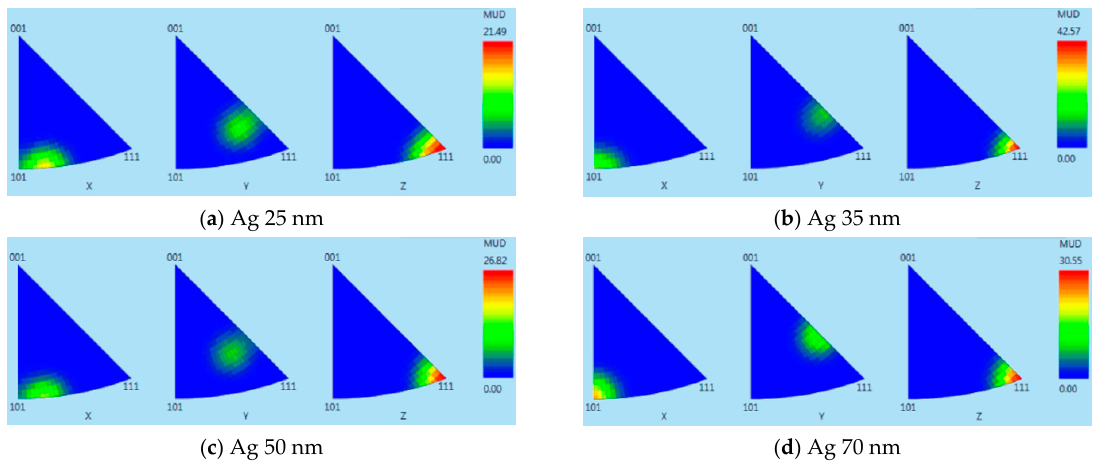
Figure 6. Inverse pole figures of <111> silver structure. ( a ) 25 nm, ( b ) 35 nm, ( c ) 50 nm, ( d ) 70 nm.